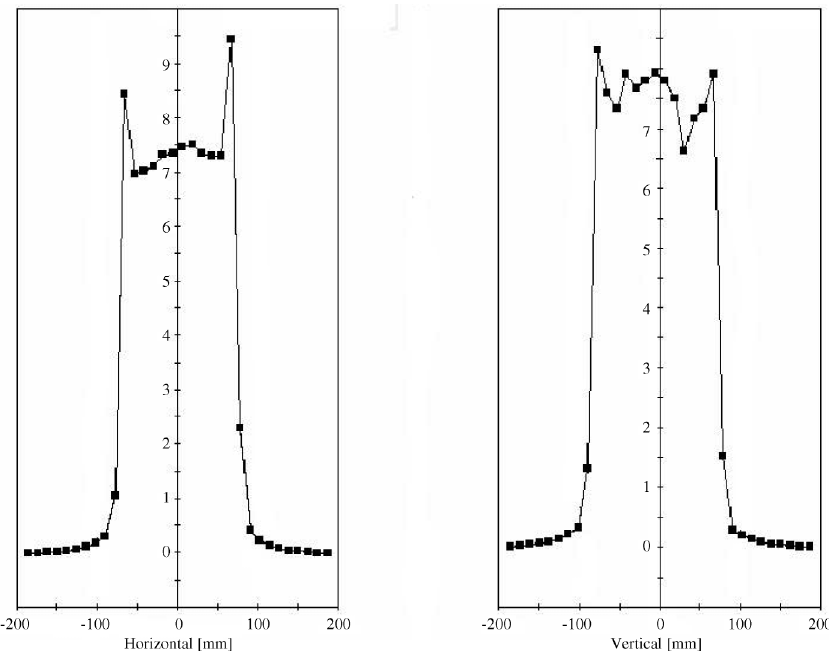
FIG. 6. The horizontal and vertical projections of the beam’s distribution at the NSRL target location when the octupoles O1, O2, shown in Figs. 3 and 4 are ON.